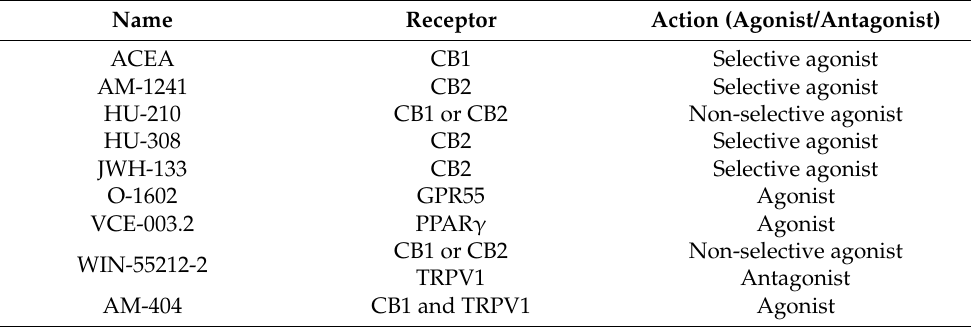
Table 1. Synthetic cannabinoids. List of synthetic cannabinoids mentioned in this review, with the receptor where they normally exert their effect.